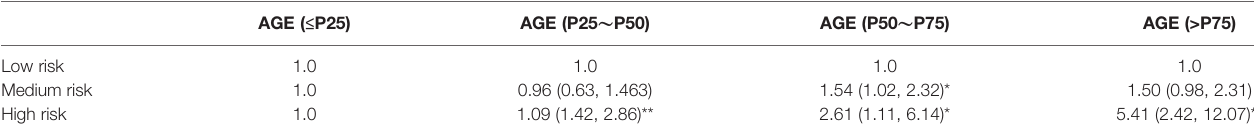
TABLE 4 | The multilevel logistic regression of risk factors and AGE.